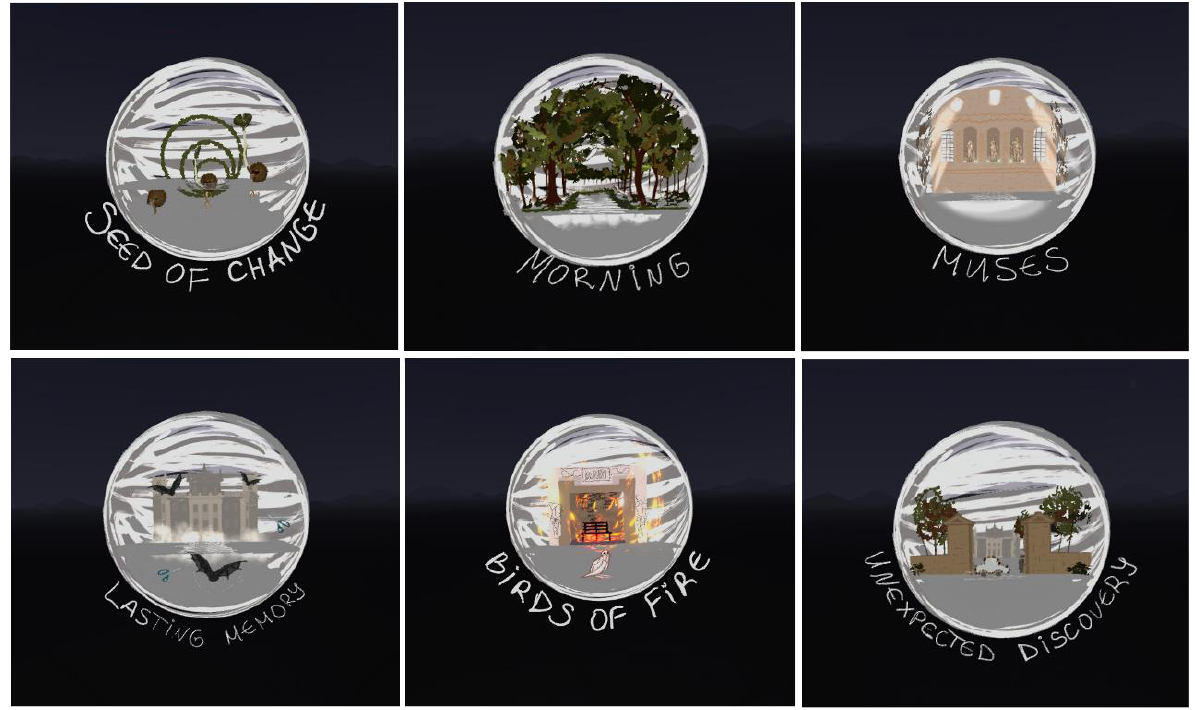
Figure 5. The six 3D gaze targets, courtesy of Violeta Tsenova as the artist.